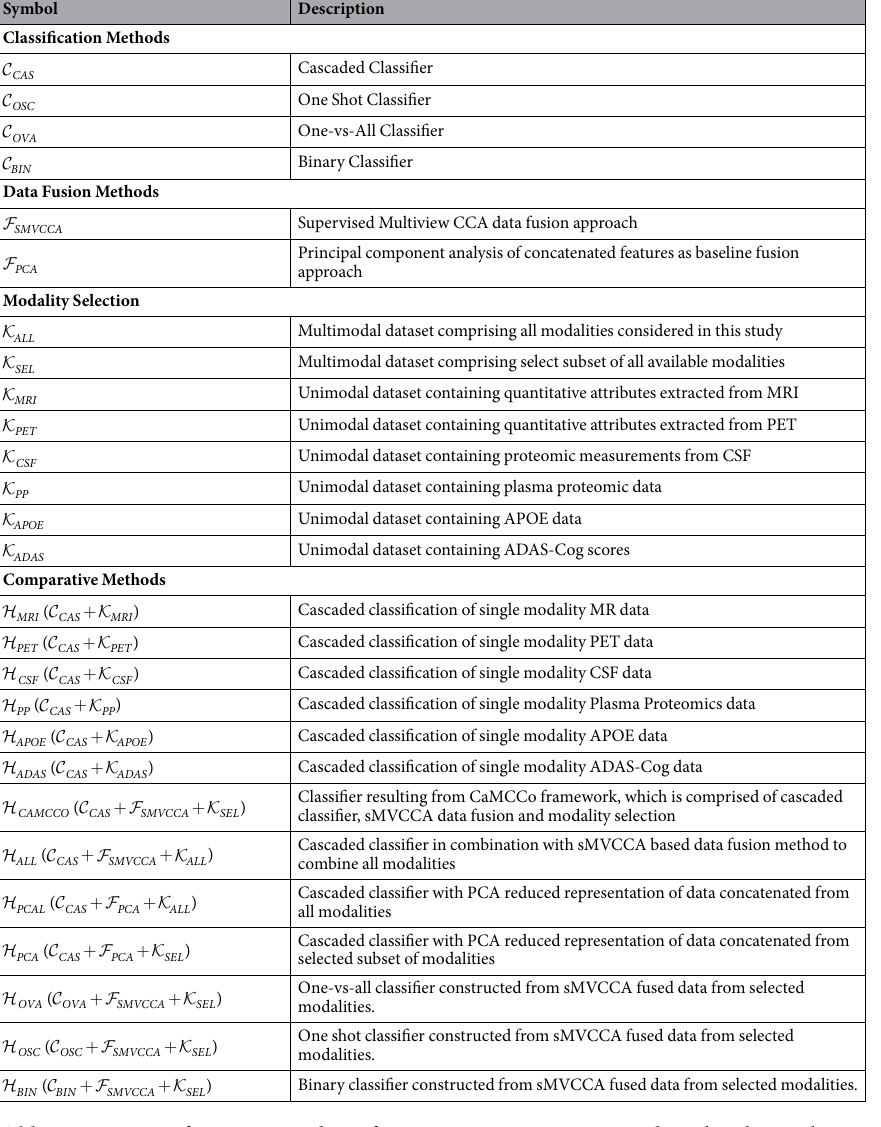
Table 5. Summary of notations used to refer to comparative strategies evaluated in this